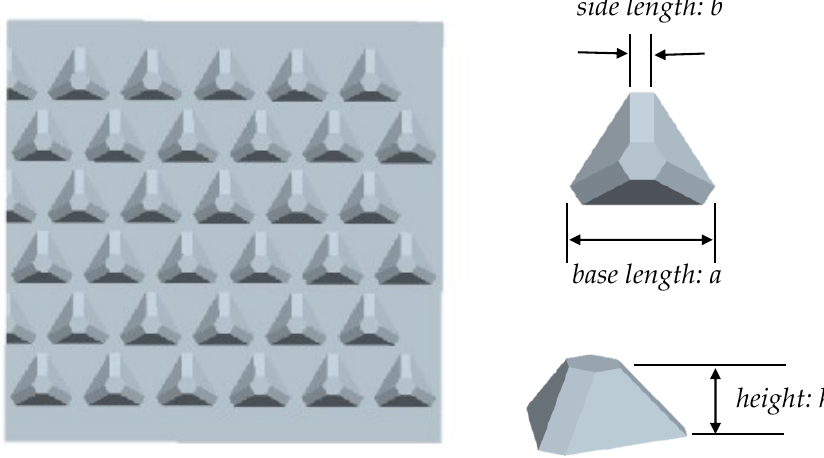
Figure 1. Geometry of the truss core panel and truss core shape parameters.